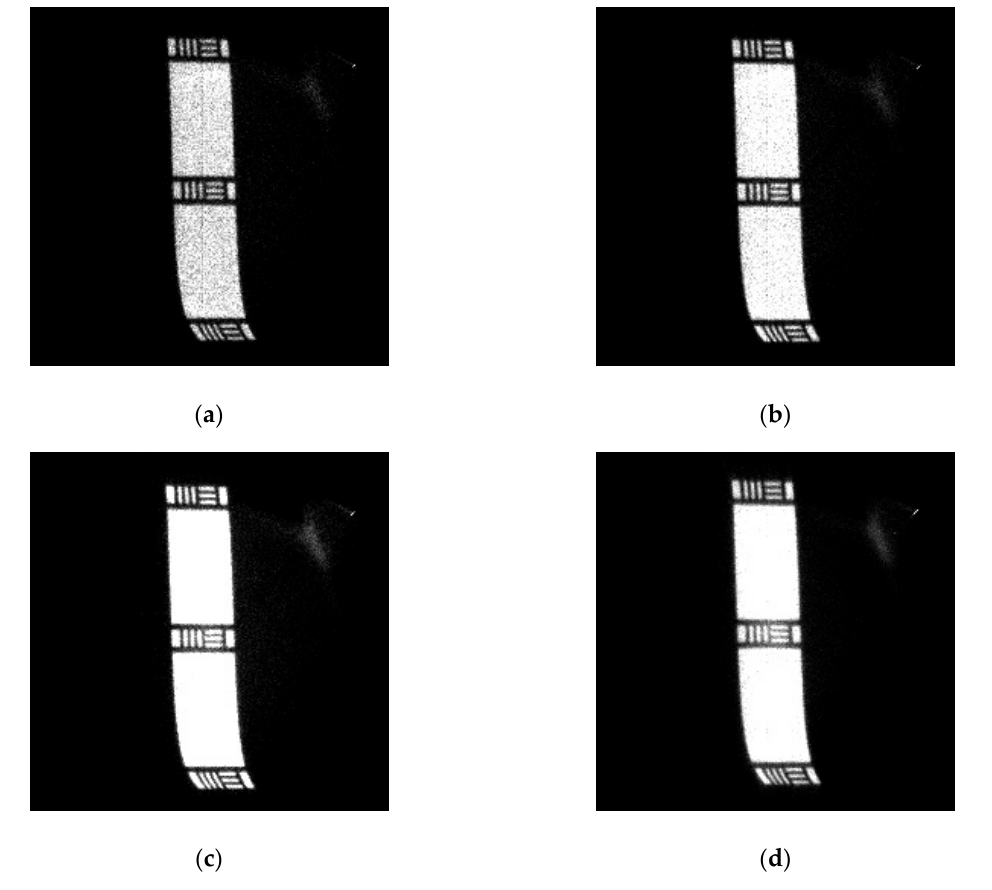
Figure 18. Special pattern imaging to verify locally high incident intensity: ( a ) incident intensity at 200 kcps; ( b ) incident intensity at 300 kcps; ( c ) incident intensity at 400 kcps; ( d ) incident intensity at 500 kcps. Table 1. Test Results of WAI and